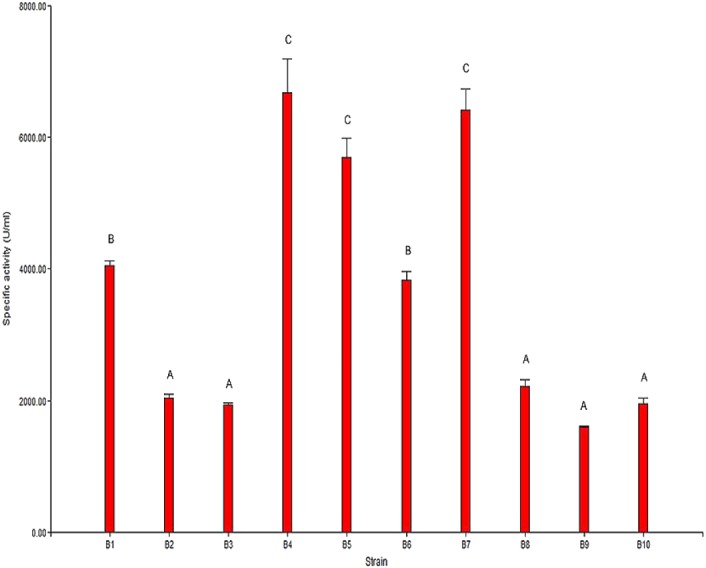
Specific chitinolytic activity of the selected strains.Values with the same letters (A, B or C) are significantly similar (P > 0.05).